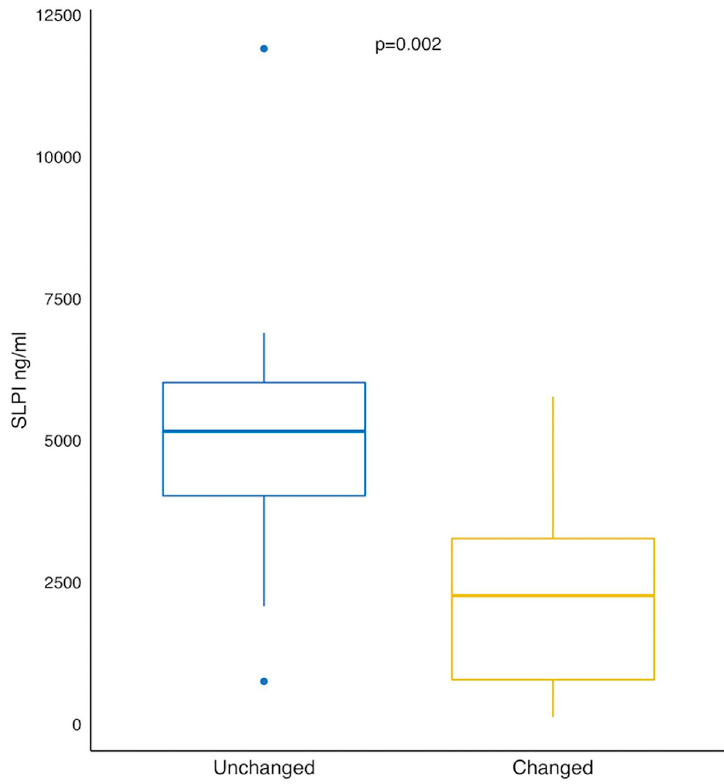
Fig 5. Comparing Secretory Leukocyte Protease Inhibitor (SLPI) measured in induced sputum in exacerbated COPD patients with regards to microbial composition alterations between disease states. Unaltered = Yue-Clayton dissimilarity index < 0.2 (n = 10), Altered = Yue-Clayton dissimilarity index > 0.2 (n = 26). Boxes show the interquartile range (IQR = 75 th percentile-25 th percentile), with medians marked by the horizontal line within each box. Kruskal Wallis test used due to non-parametric